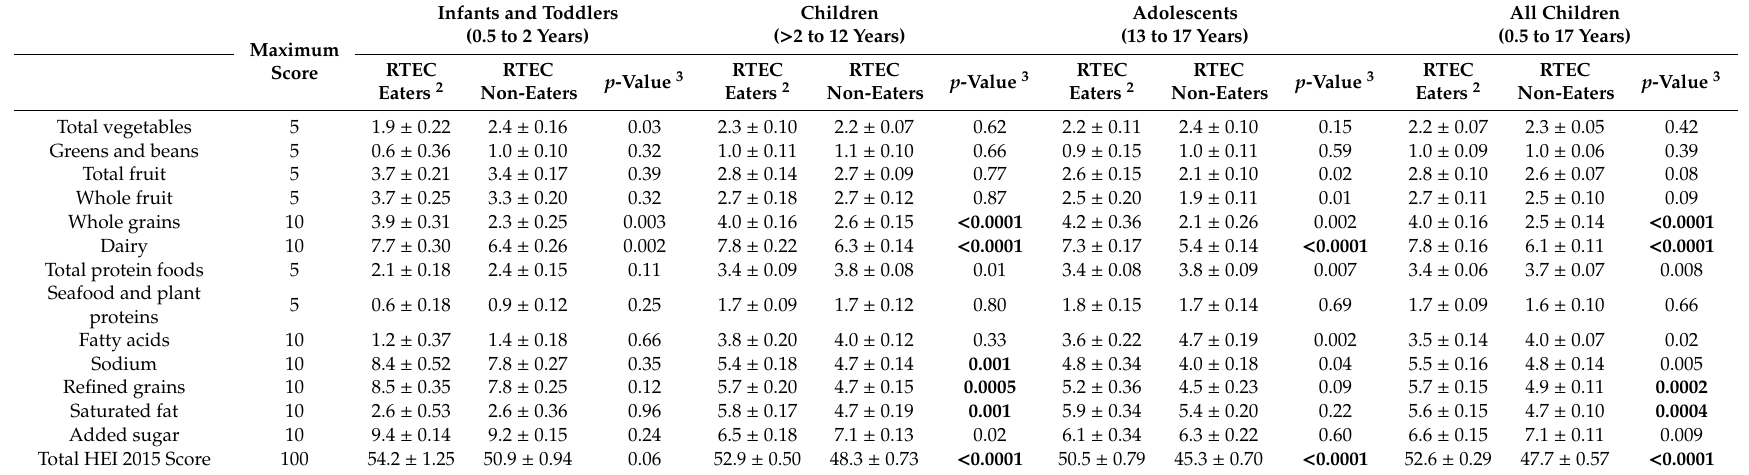
Table 4. Healthy Eating Index score and subscores for children aged 0.5 to 17 years, by RTE cereal eating status from the Food Patterns Equivalents